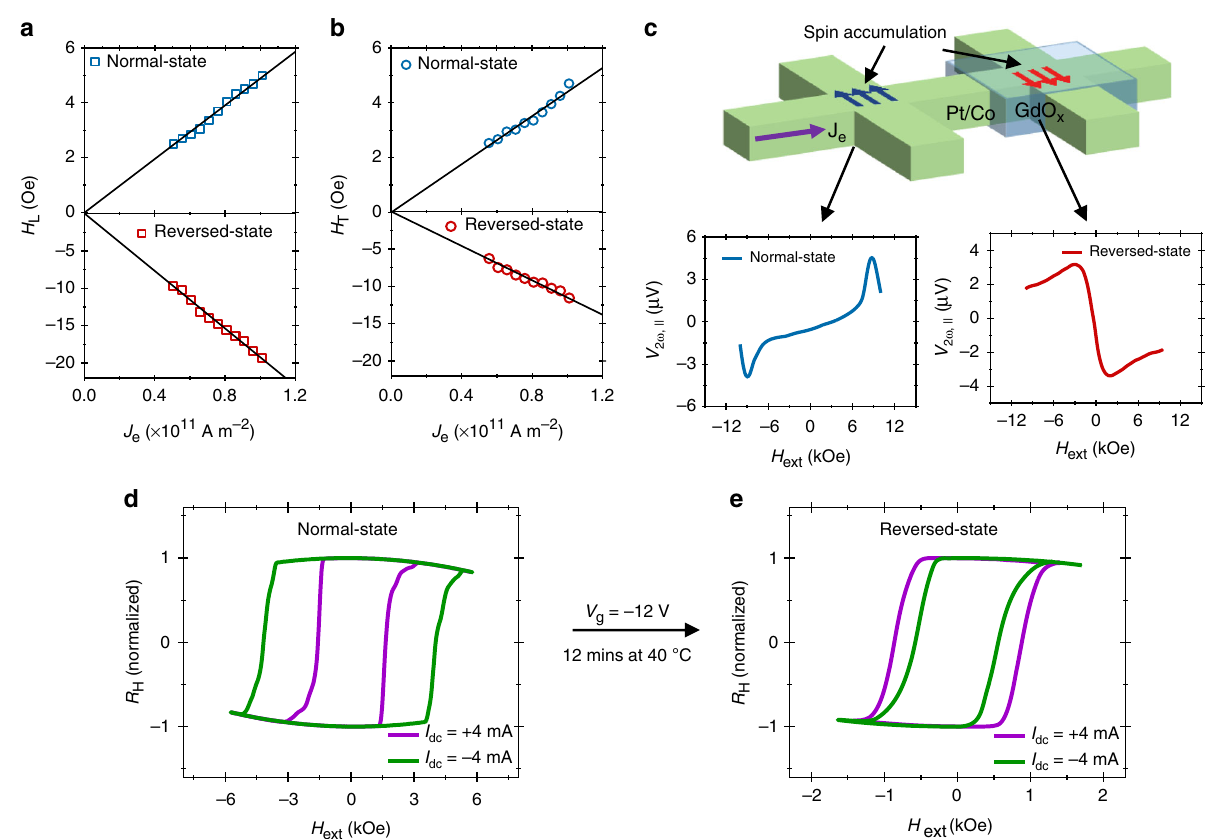
Fig. 2 Current-dependence of effective fi elds and programmable spin accumulation. a , b Longitudinal ( a ) and transverse ( b ) effective fi elds ( H L and H T ) as a function of current density ( J e ) for a Pt (2 nm)/Co (0.8 nm) Hall bar device. The solid lines are the linear fi ts. Measurements were done at 150 K. c Schematic of a two-bit Hall bar with one of the bit covered by gate oxide. Bottom fi gures show the second harmonic signals measured at room temperature in different regions of 2-bit Hall bar. The red and blue arrows in the schematic represent the current-induced spin accumulation directions. d , e Normalized Hall resistance ( R H ) versus in-plane external magnetic fi eld ( H ext ) in the presence of a dc current ( I dc ) for a Pt (2 nm)/Co (0.8 nm) device in the normal state ( d ) and after reversing its state ( e ). Measurements were performed at 250 K at which the reversed device regained